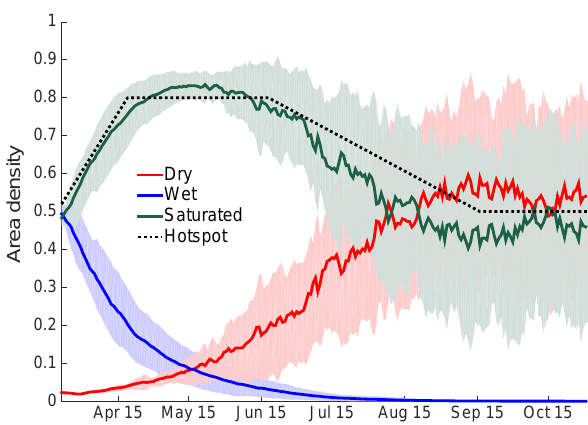
Figure 2. Area densities for dry (red line), wet (blue line), and sat- urated (green line) grid cells. The solid lines represent the different surface class dynamics averaged over 30 years, from 1976 to 2005. Shaded areas represent standard deviations over the same period of time. The dynamics of the saturated grid cells are mimicked by the empirical Hotspot parameterization (black dotted line), Eq. (7) in the text.